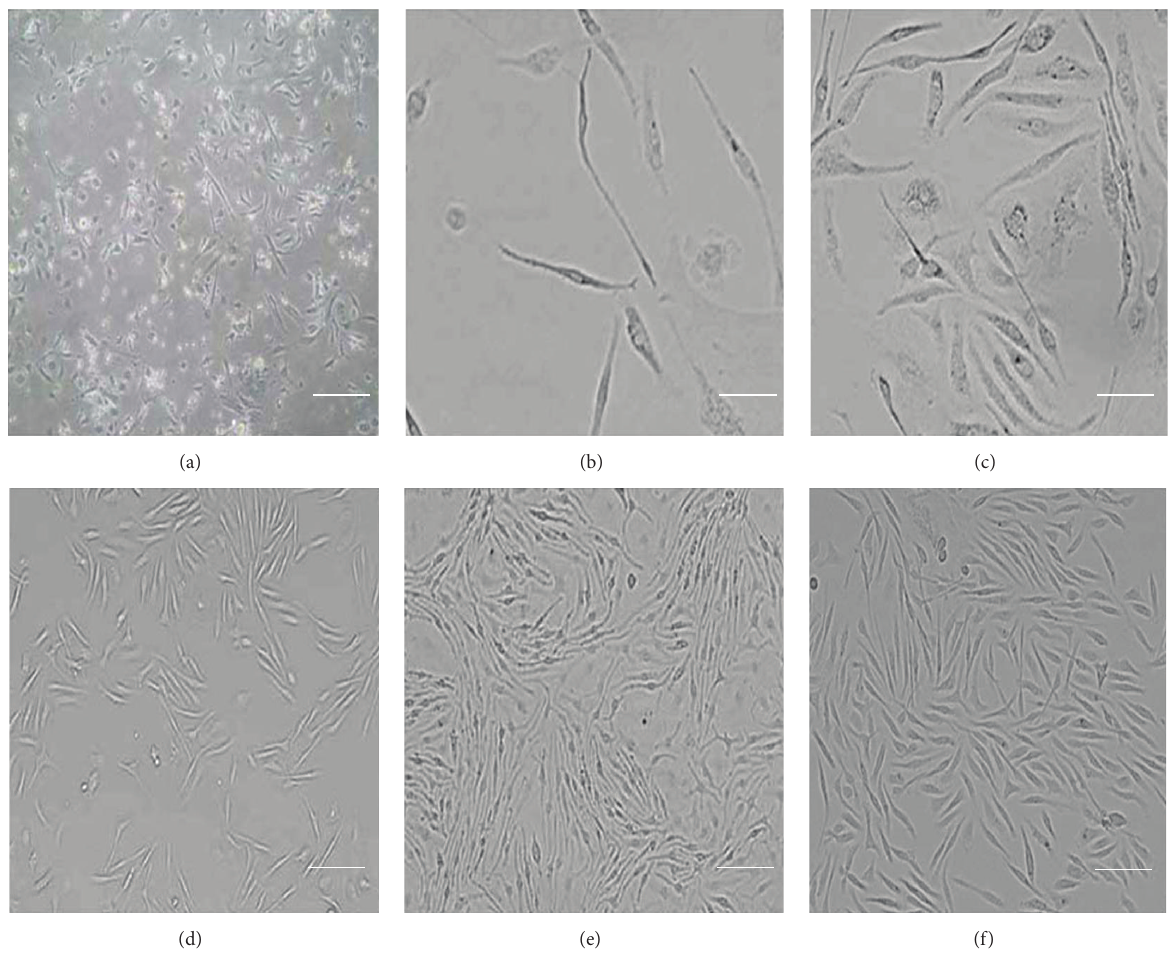
Figure 2: Morphological observation of liver-derived mouse stem cells. (a) LDSCs of different morphology were observed on 2nd day of culture (b, c) and after 3rd day elongated spindle shaped LDSCs were predominately observed from the initial culture. (d) LDSCs at their 60% confluency. (e) LDSCs at more than 90% confluent on day 6 of initial culture. (f) Passaged (P1) LDSCs at their 60% confluency. Scale bars represent 100 𝜇 m (a, d, e, and f) and 50 𝜇 m (a and